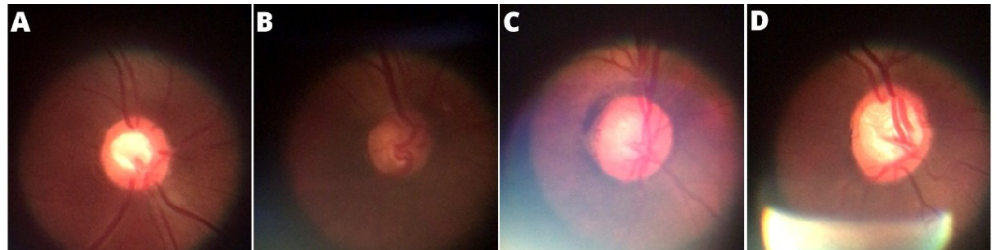
Figure 7. Main noise types presented in the panoptic ophthalmoscope images: ( A ) ideal image, ( B ) low lighting, ( C ) external noise, ( D ) light focus noise.